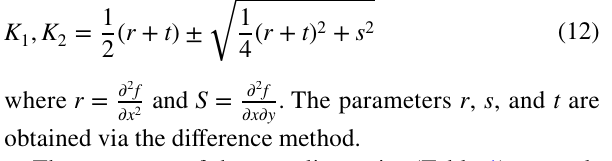
c the relationship between porosity and permeability at an anticline, d the relationship between porosity and permeability at a